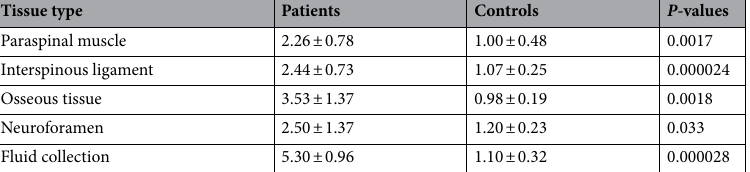
Table 2. SUV max (mean ± standard deviation) from detected lesions of the patient group and corresponding regions of the control group for different tissue